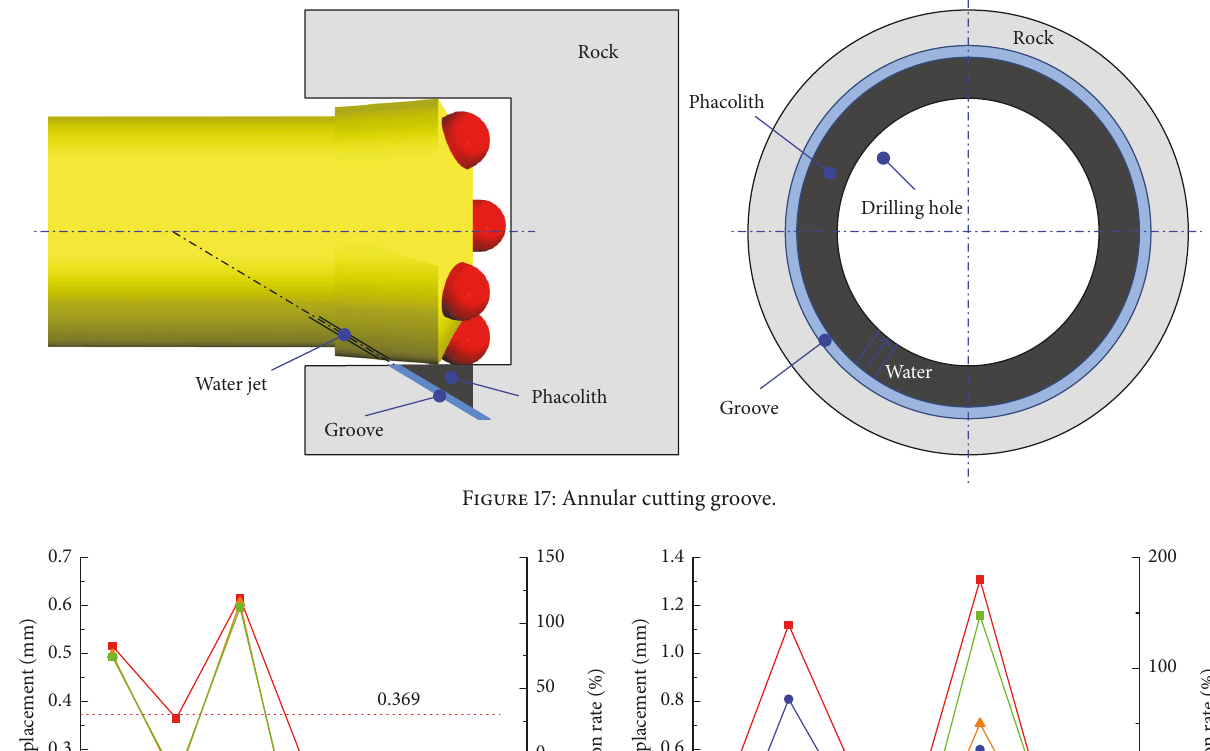
Figure 17: Annular cutting groove.